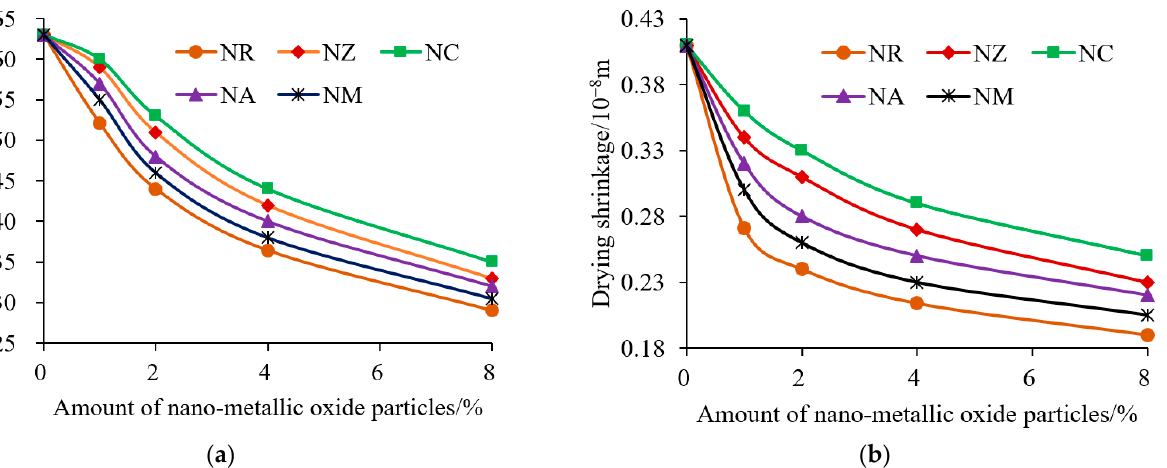
Figure 6. Drying shrinkage of cement mortar with nano-metallic oxide particles: (a) 28 days; (b) 730 days.